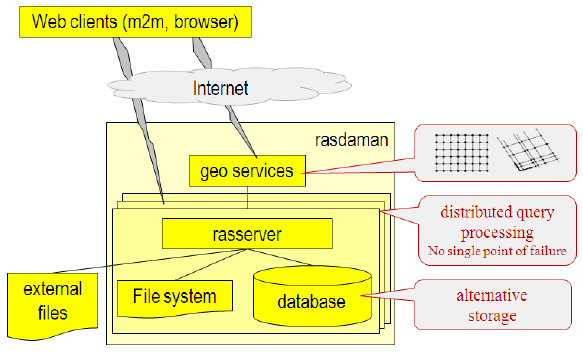
Figure 7. rasdaman federation architecture